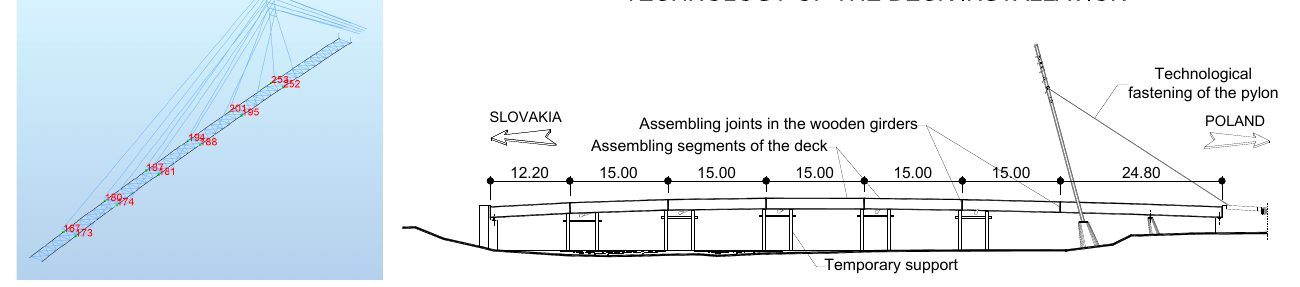
Figure 13. Location of assembling joints.